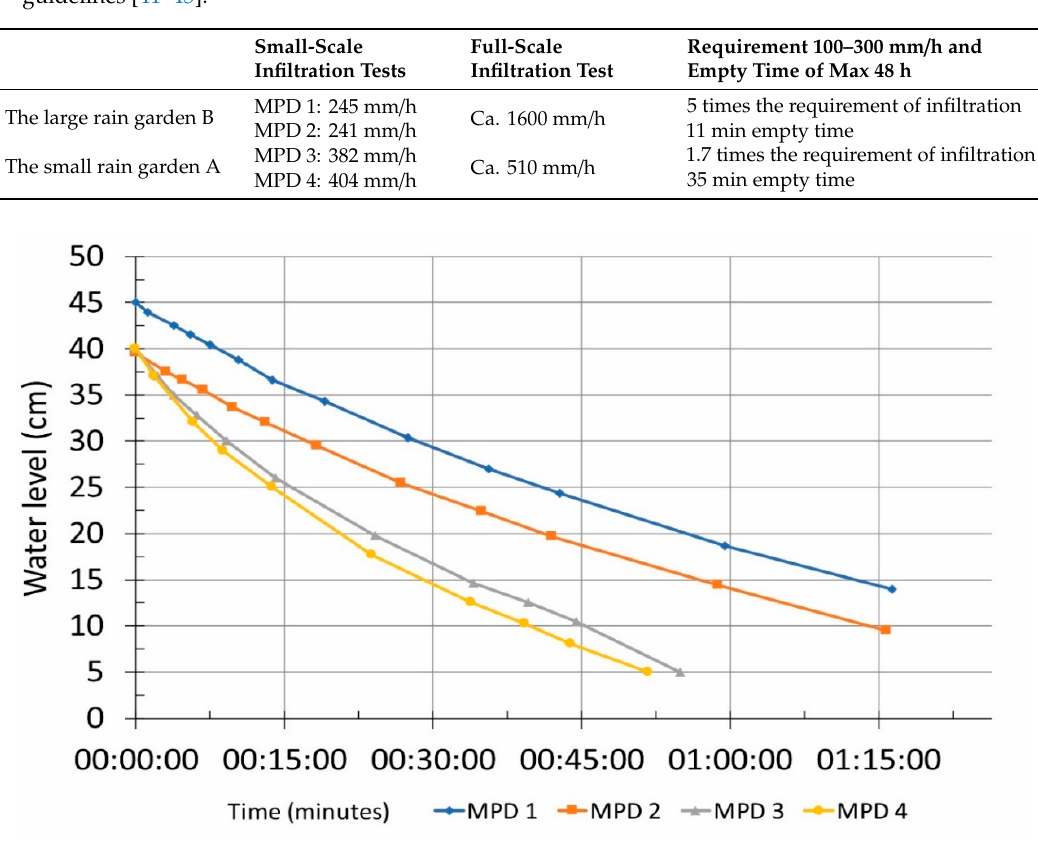
Figure 10. Results of the MPD infiltration test in rain garden A and B. MPD 3 and 4 were measured in compartment A and MPD 1 and 2 in compartment B.